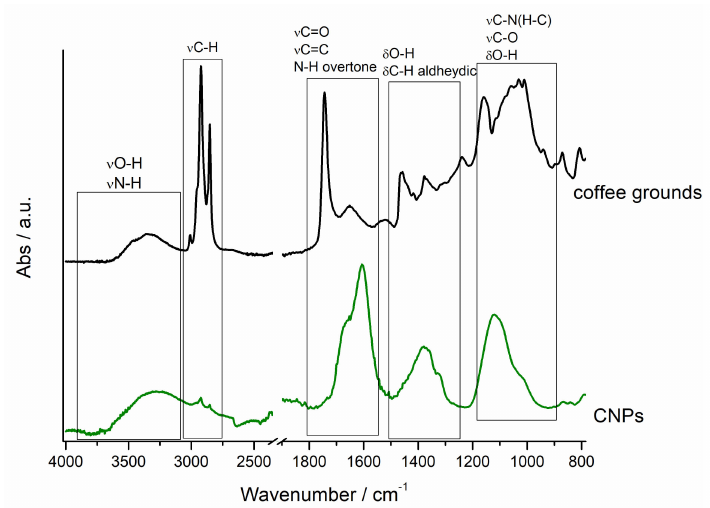
Figure 3. FT-IR spectra of coffee grounds and